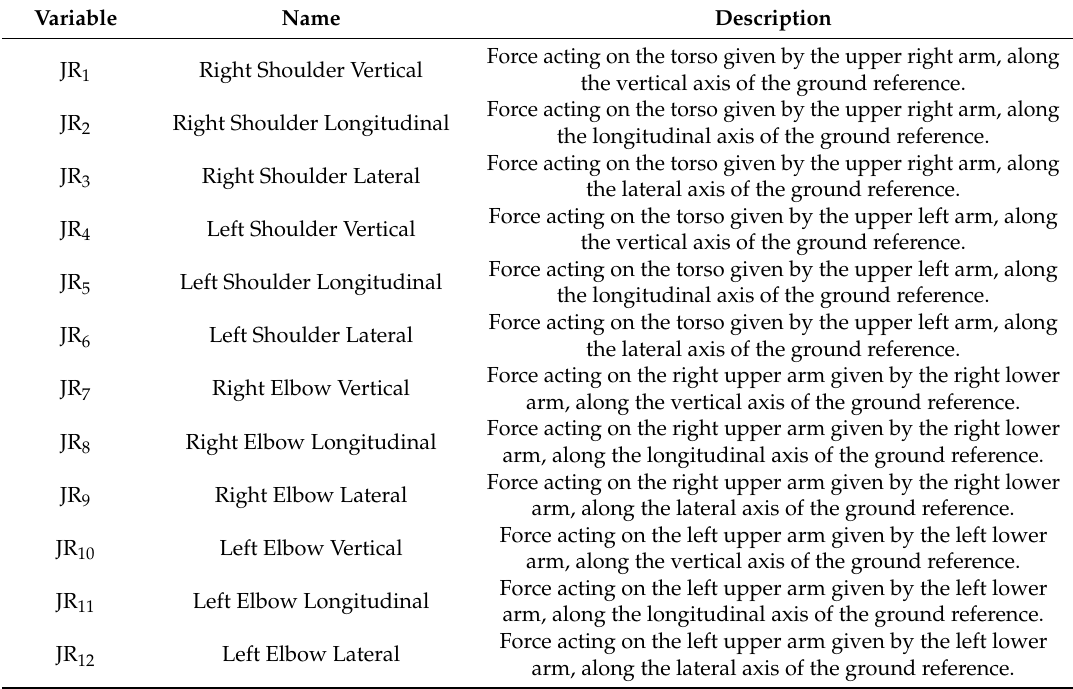
Table 2. Upper joints’ internal reaction forces used as a benchmark.